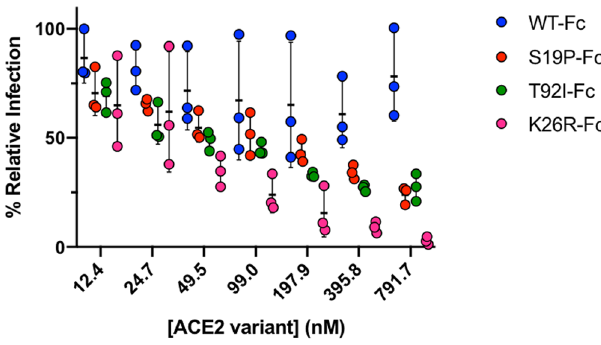
Fig. 5 ACE2 variants block pseudotyped SARS-CoV-2 virus infection. Inhibition of pseudovirus entry into HEK293T cells by ACE2 WT and mutants S19P, T92I, and K26R. A range of seven different concentrations of Fc-tagged ACE2 proteins were mixed with pseudoviruses and the infectivity was measured by the luciferase signal as an indication of the amount of virus entering the cells. Data are presented as the mean ± SD (standard deviation). Sample size n Supplementary Fig. 7, Supplementary Data 4) 30,31,46,47 . These ACE2 variations are expected to abolish glycosylation at N90 46 .